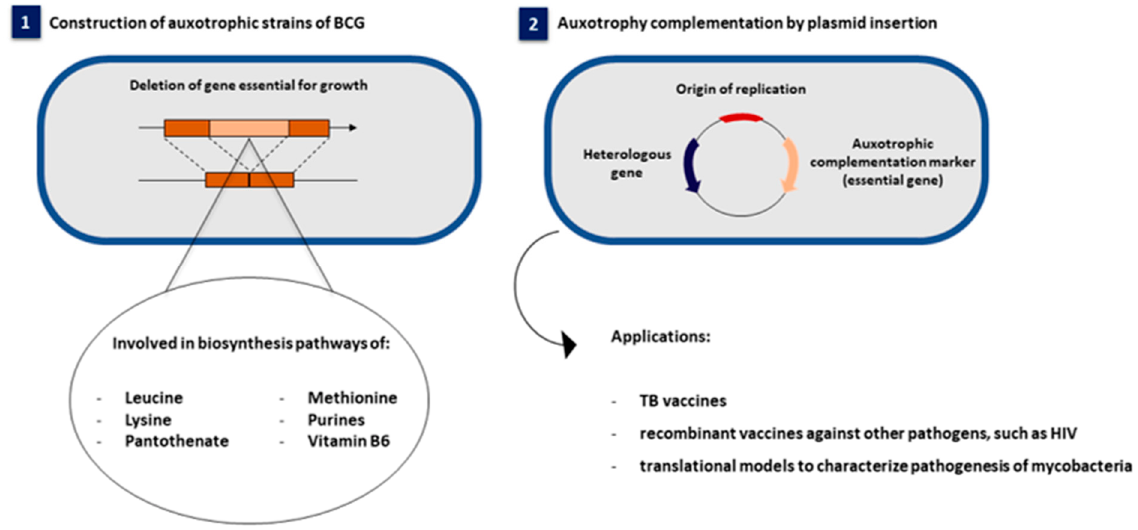
Figure 1. Schematic representation of the construction and applications of auxotrophic strains of BCG. ( 1 ) Development of auxotrophic strains of BCG from mutations or deletion of genes required for their growth, such as those involved in biosynthesis pathways of purines and amino acids; ( 2 ) Systems for auxotrophy complementation by plasmid insertion and applications of BCG auxotrophs.